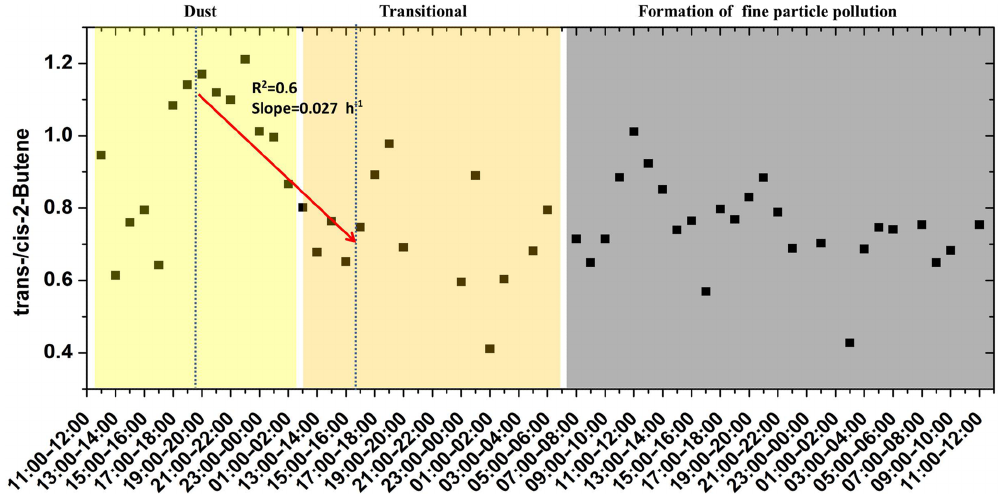
Figure 4. Temporal variations in trans -/ cis -2-butene ratios in the dust, transitional, and fine particle pollution periods.